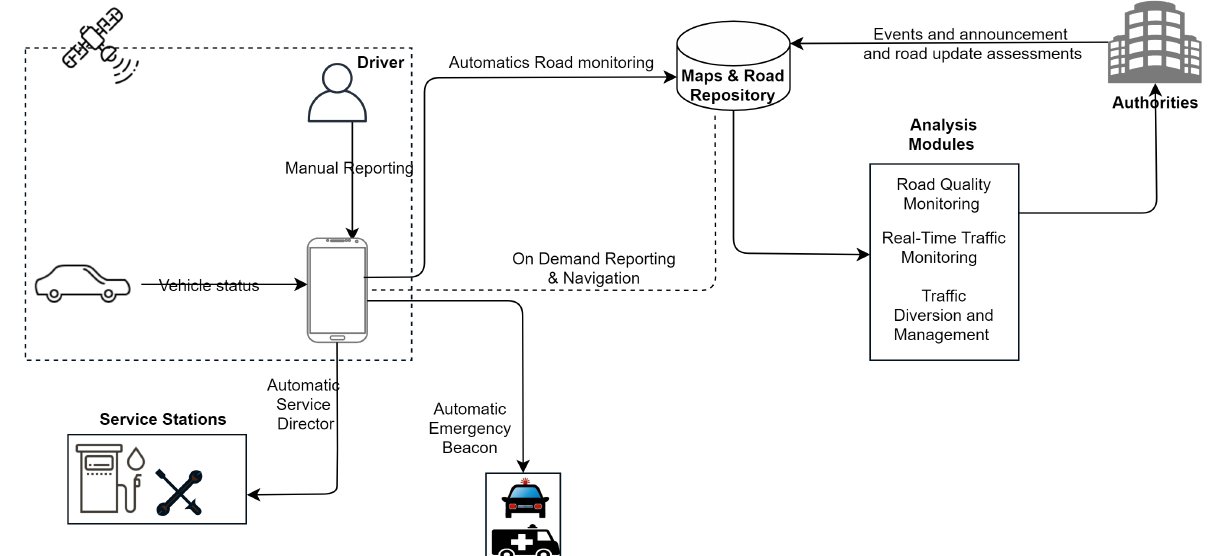
Figure 12. Independent map framework